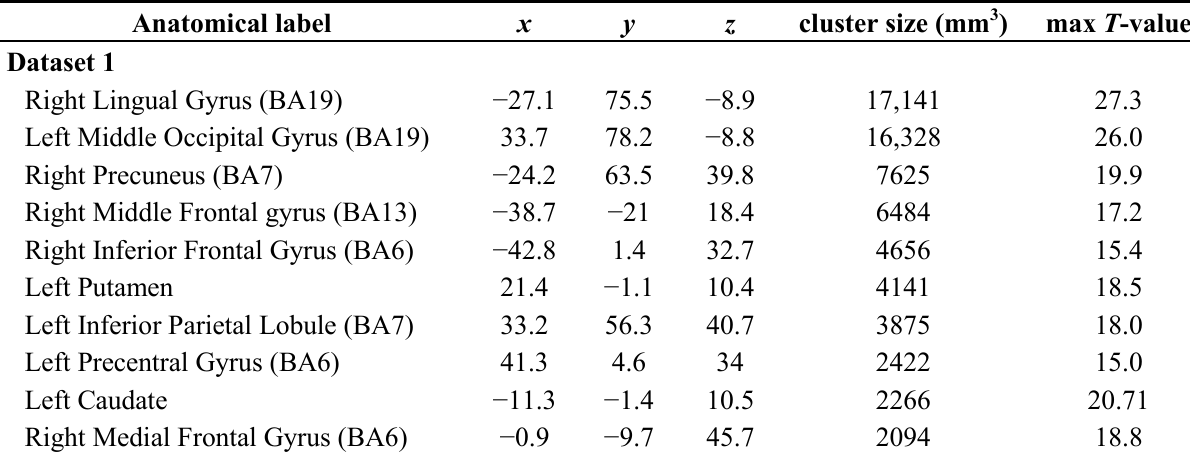
Table 4. Cluster information for the fMRI contrast of C vs . NC trial types (Figure 5) in Dataset 1 and Dataset